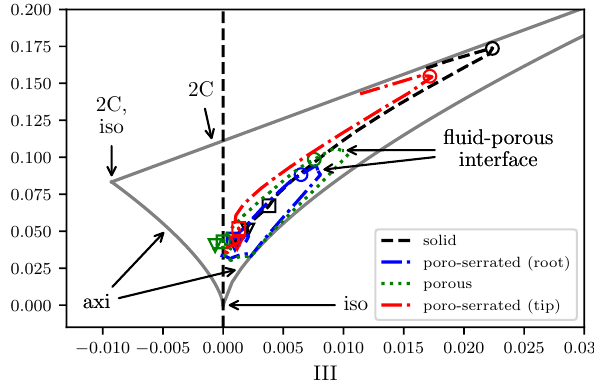
Figure 9. Anisotropy map at x / c = 0.1 with the distributions describing the turbulence state, − when traversing from the solid wall or inside the porous medium to y + = 200. Markers indicate the distances y + = 7 ( ), y + = 50 ( (cid:3) ) and y + = 100 ( (cid:79) ) from the (cid:13)